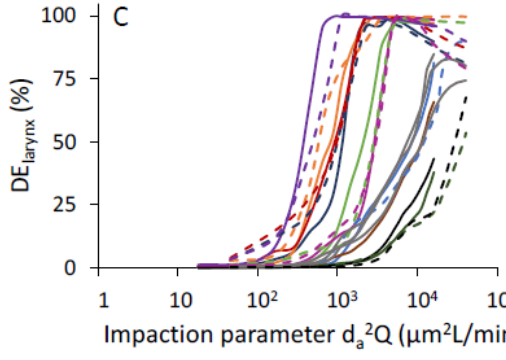
Figure 6. Expiratory regional deposition (DE) vs. inertial impaction parameter. Solid and dashed lines represent deposition fraction at exhalation flowrate of 18 (L/min) and 45 (L/min), respectively. ( A ): Mouth. ( B ): Oropharynx. ( C ): Larynx.